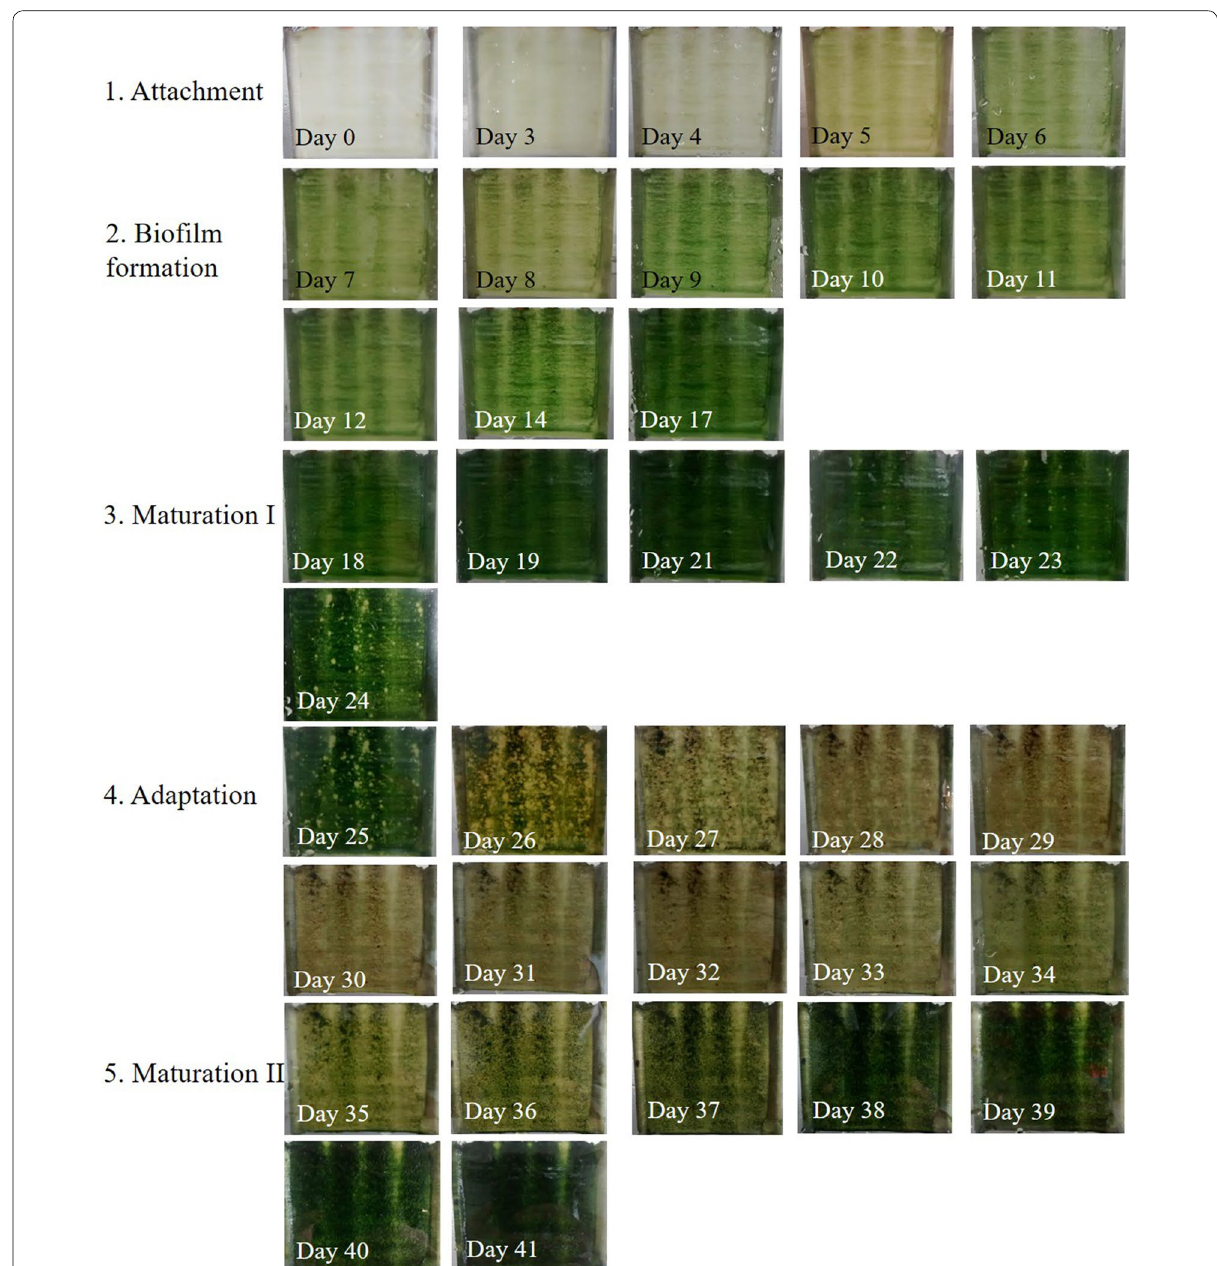
Fig. 3 Biofilm development phases observed in the biofilm growth of S. vacuolatus ACUF 053 in the